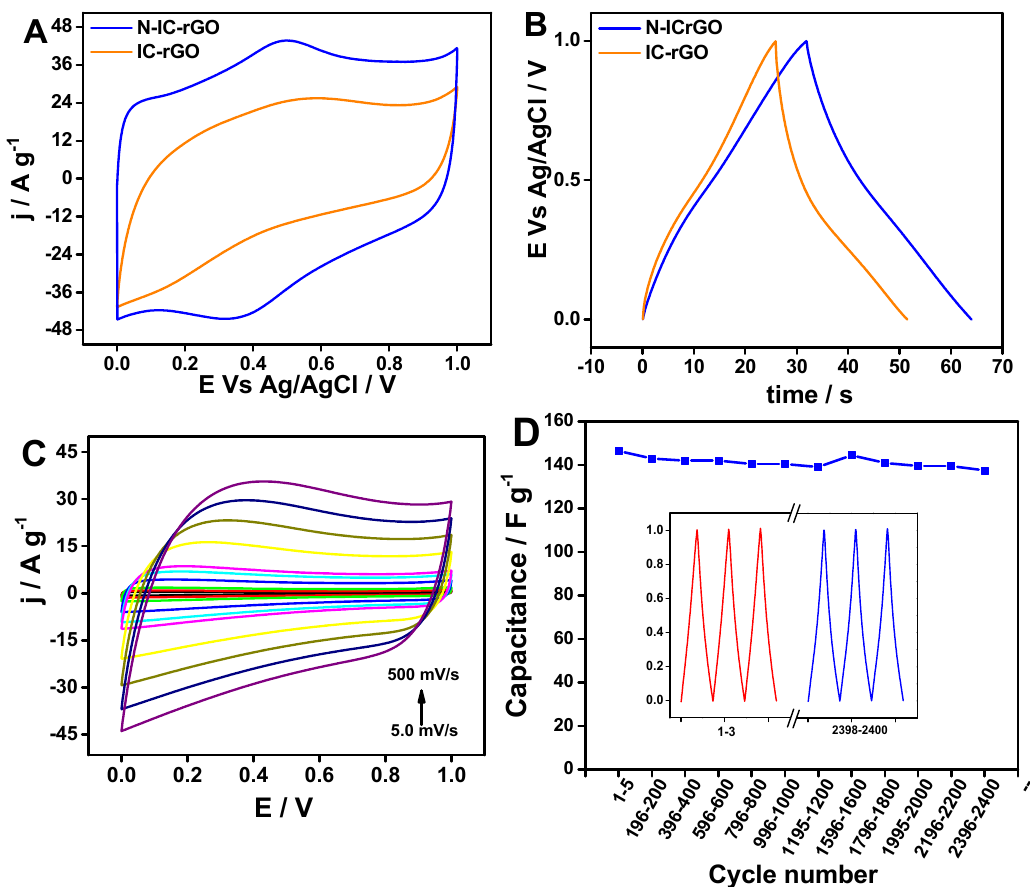
Figure 6. ( A ) Cyclic voltammogram with 0.1 V s − 1 scan rate on the IC-rGO and N-IC-rGO-modified GCE. ( B ) Constant current charge/discharge curves of IC-rGO and N-IC-rGO (performed in 0.5 M